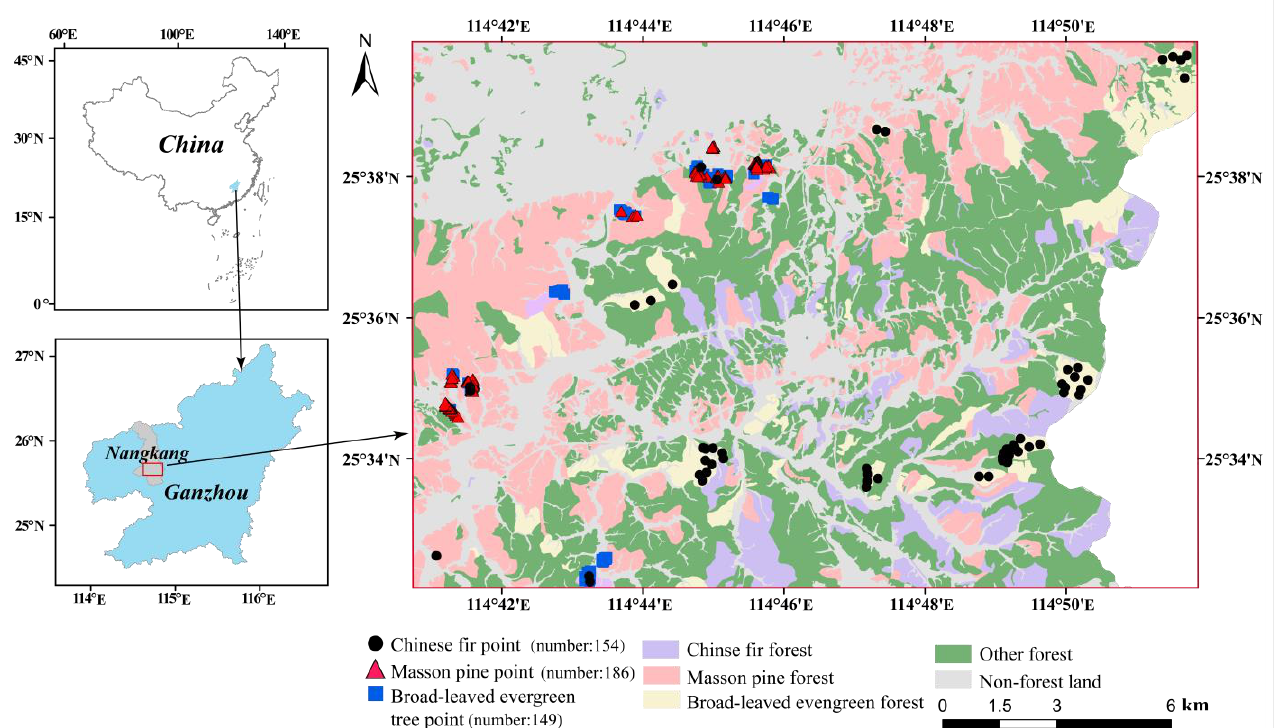
Figure 1. Nangkang study area and sample points distribution.